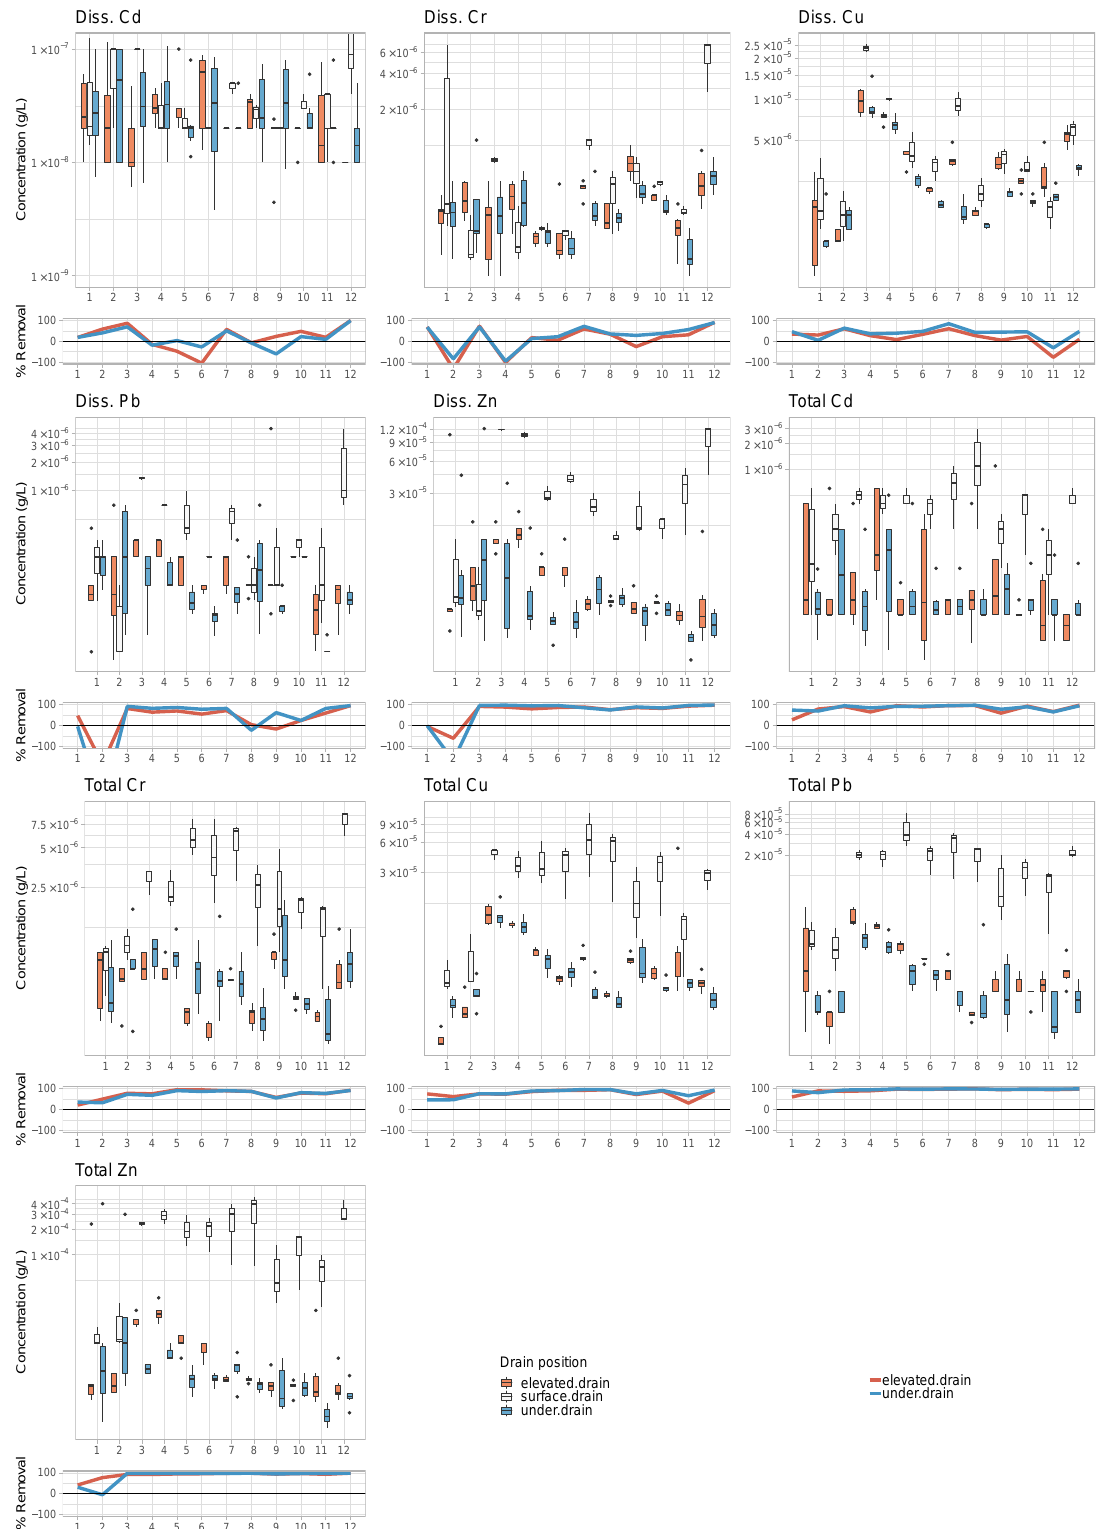
Figure 5. Removal efficiencies for total and dissolved heavy metals at elevated drain and under drain positions. Removal efficiencies below − 100% (or over 100% export) are not shown, and why some line graphs appear